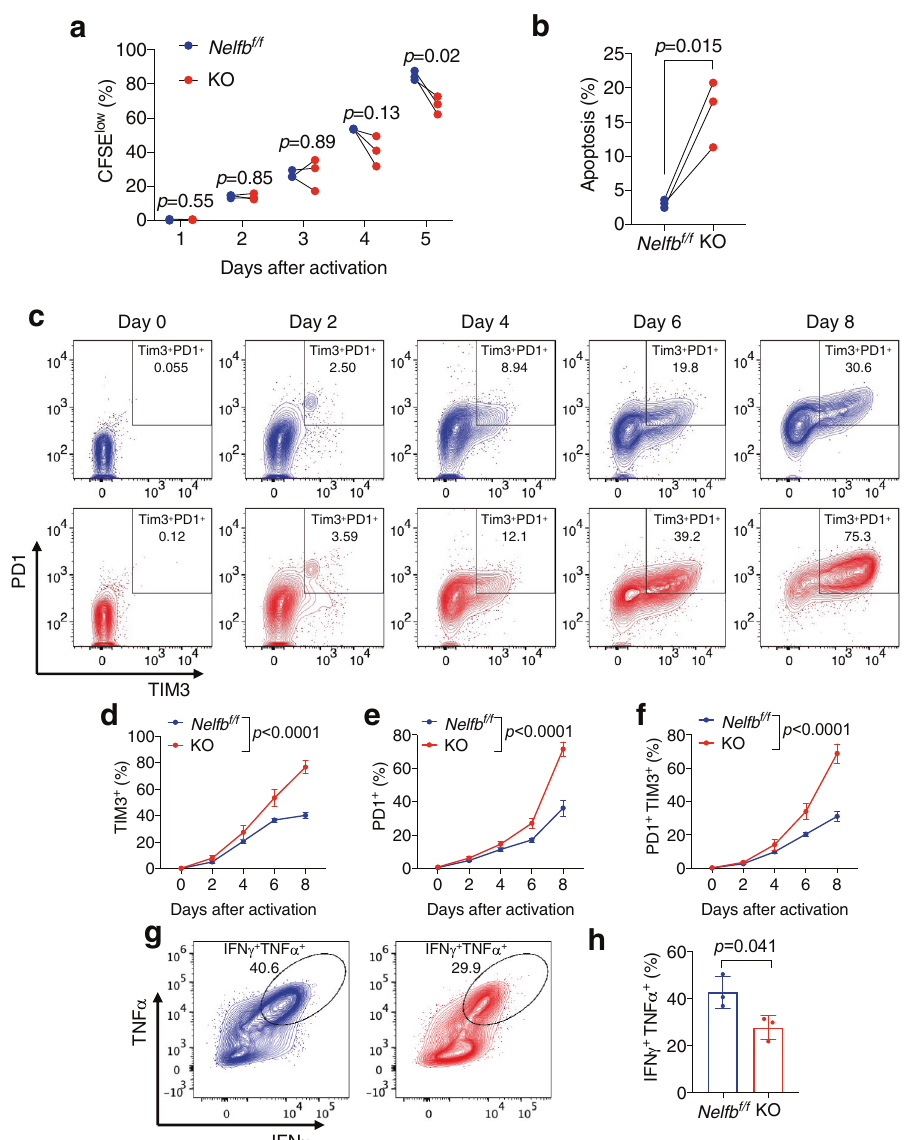
Fig. 3 Nelfb deletion promotes apoptosis and exhaustion of CD8 + T cells. a Time course of CFSE low population as a percentage of Nelfb f/f and KO CD8 + T cells cultured in vitro, n = 3/group. b Percentages of apoptotic cells among Nelfb f/f and KO CD8 + T cells after 24 h of anti-CD3/CD28 activation, assessed by annexin V-APC/PI for fl ow cytometric analyses, n = 3/group. c Representative fl ow cytometry plot of the time course for TIM3 + PD1 + double- positive exhausted cells among Nelfb f/f and KO CD8 + T cells cultured in vitro. d – f Percentages of TIM3 + ( d ), PD1 + ( e ), and PD1 + TIM3 + ( f ) cells within Nelfb f/f and KO CD8 + T cells cultured in vitro, n = 3/group. g Flow cytometry plot of TNF α + IFN γ + double-positive polyfunctional T cells. h Percentages of Nelfb f/f and KO CD8 + T cells after 10 days of in vitro culture, n = 3/group. Data were presented as mean ± SD; mean differences were compared using Student ’ s t -test. Time-dependent curves were compared using two-way ANOVA followed by multiple comparisons. Two-sided tests were used. Source data are provided as a Source Data fi